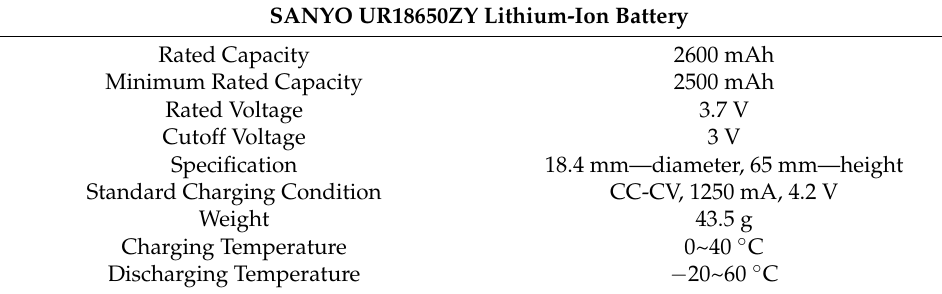
Table 2. UR18650ZY specification table [36].